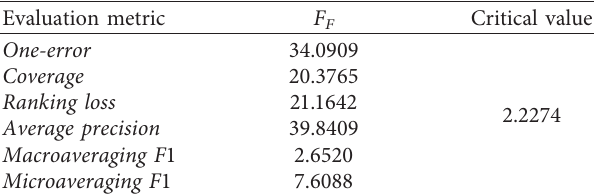
Table 4: The Friedman statistics F